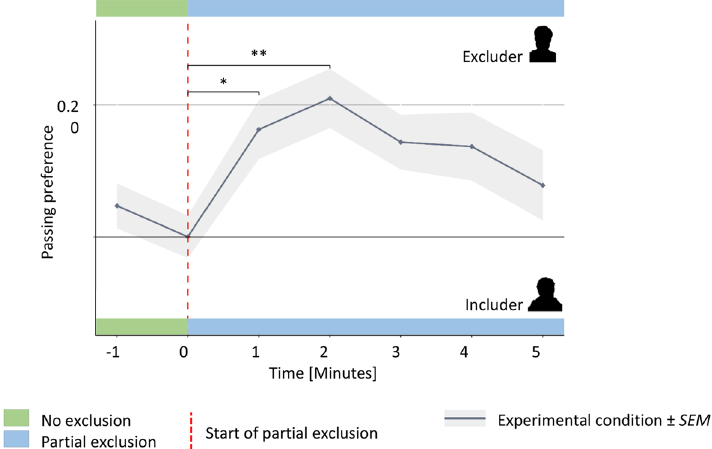
Figure 2. Experiment 1—Trajectory of passing preferences. ( B ) Mean passing trajectories over the course of experiment 1. Passing preferences (PP) were calculated for each minute according to formula [1]. The gray shaded area shows the associated standard errors of means. Dashed red line represents transition from period of no exclusion to partial exclusion period. Asterisks representsss significant Tukey corrected differences in mean passing tendency. * p < 0.05; ** p < 0.01; *** p < 0.001.